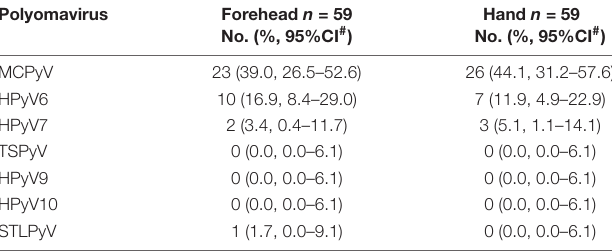
TABLE 4 | Site-specific HPyV long-term persistence.